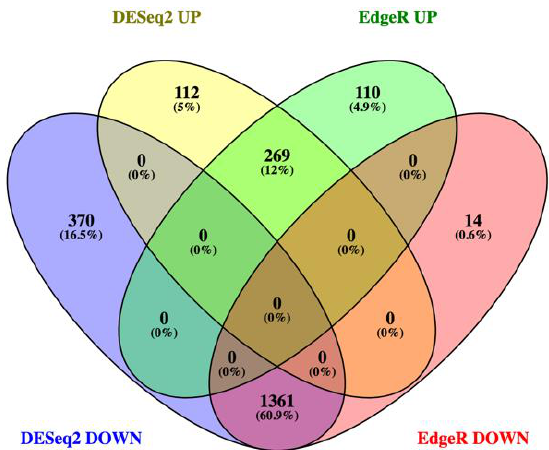
Figure 3. Venn diagram comparing the numbers of genes expressed at higher levels (UP) or lower levels (DOWN) identified by both DESeq2 and edgeR. The number of upregulated genes identified by both dESeq2 and edgeR was 269 while the number of downregulated genes was 1361. No gene was identified as upregulated by one algorithm and downregulated by the other.